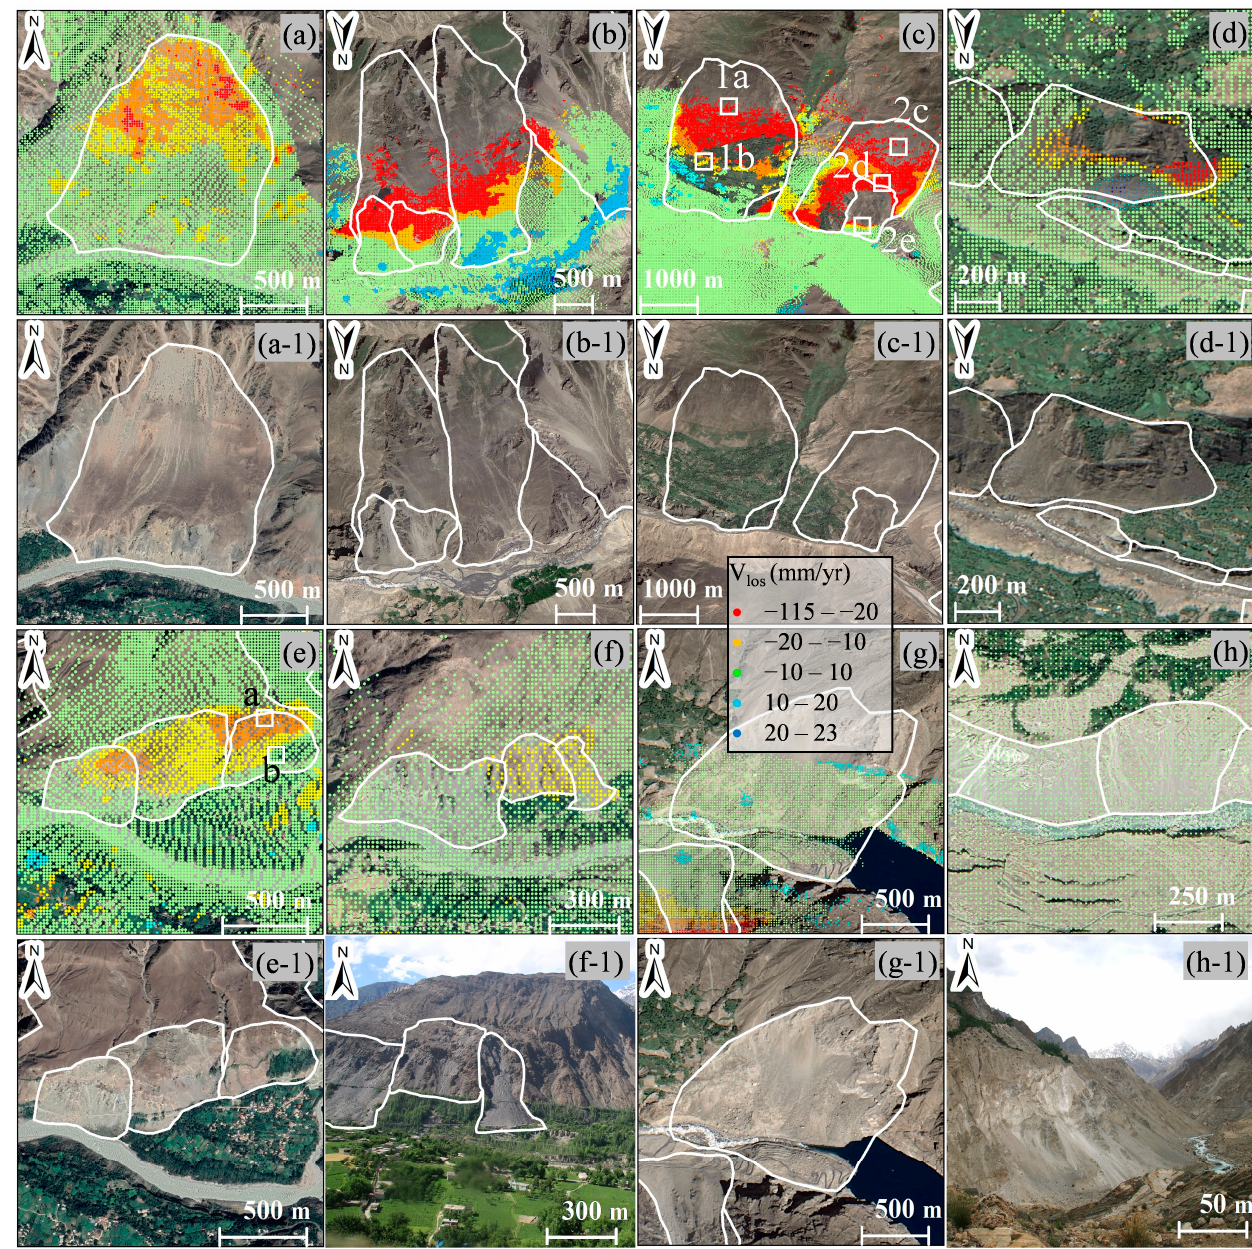
Figure 8. SBAS-INSAR monitoring deformation and the optical image interpretation of identified ( a – f ) and interpreted ( g , h ) landslides. ( a ): No. 72 Ghulmet landslide, ( b ) No. 2–6 landslides, ( c ) No. 18, 22 Humarri-1, Humarri-2 landslide, ( d ) No. 42 landslide, ( e ) No. 87-89 Mayoon-1~3 landslides, ( f ) No. 94-96 Jizalabad landslides, ( g ) No. 1 Atta Abad landslide, ( h ) No. 9-10 landslides.